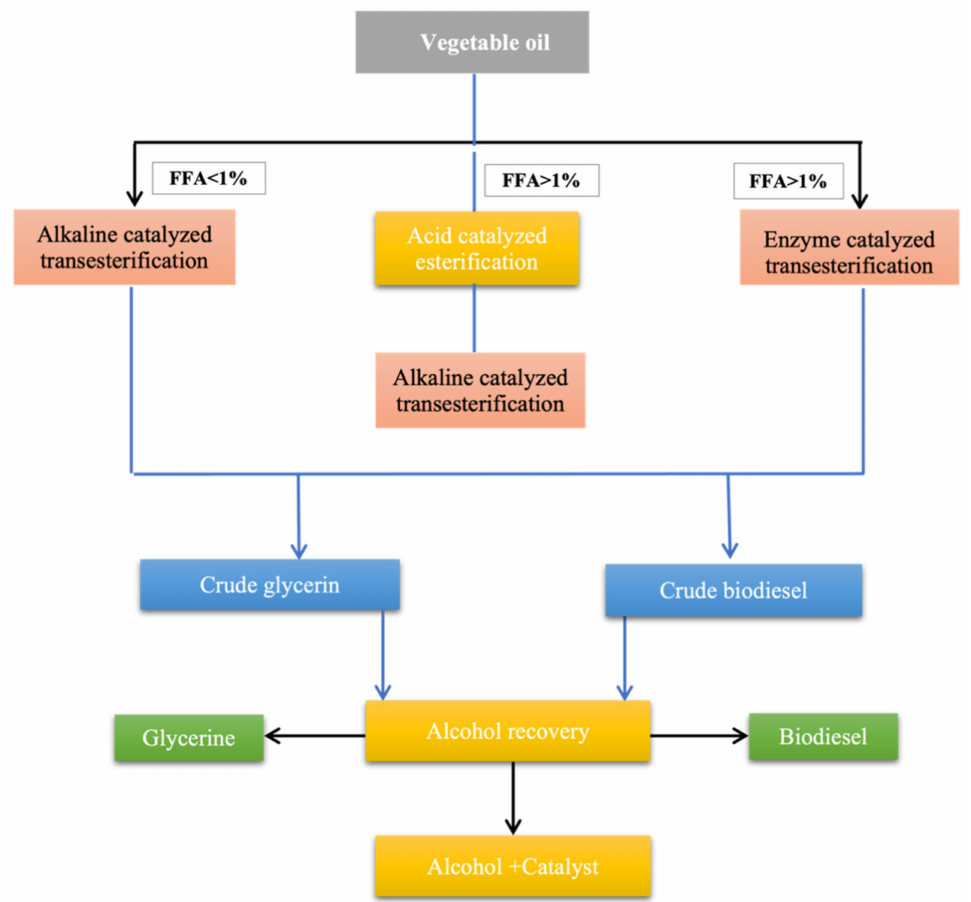
Figure 3. Biodiesel production through different transesterification